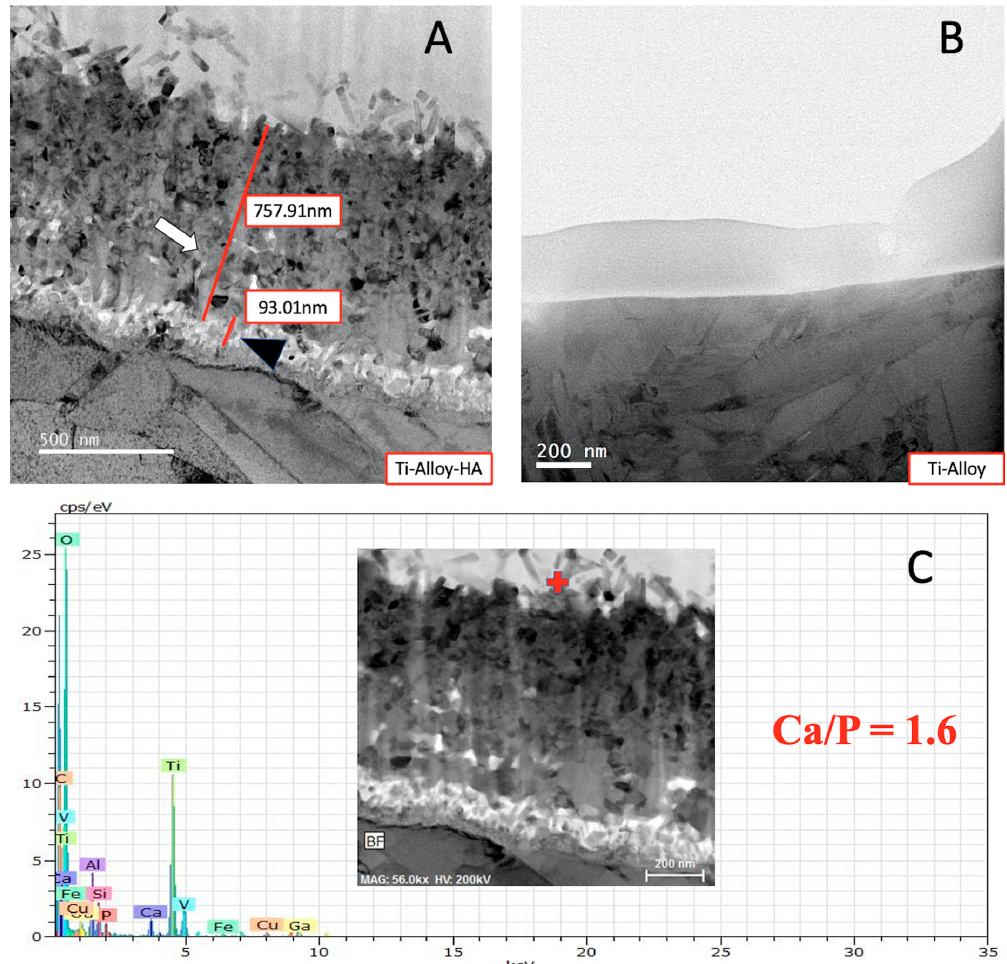
Figure 2. TEM photograhs and EDX examination. ( A ) Ti-alloy with surface modification, formation of apatite can be seen on the Ti-alloy surface (white arrow), black arrowhead denotes anatase and rutile on the Ti-alloy surface. ( B ) Ti-alloy only. ( C ) EDX on the apatite of the Ti-alloy with surface modification. Red cross marks the area of electron diffraction and EDX analysis.